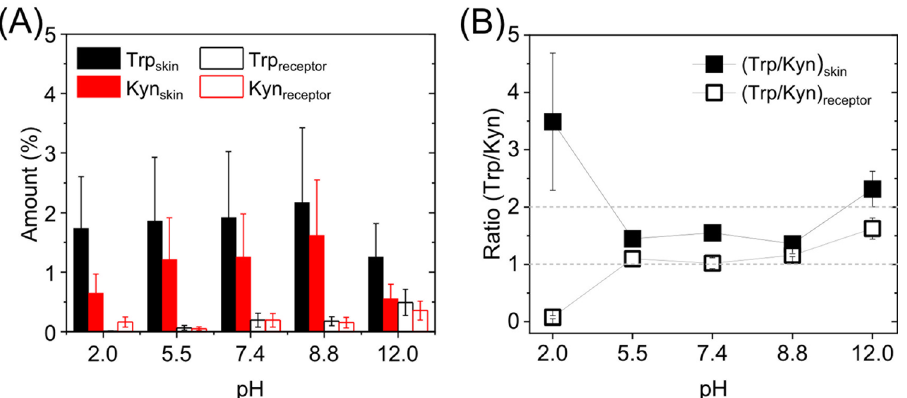
Figure 4. ( A ) Mass balance of Trp and Kyn between the skin membrane and the receptor solution as a function of pH (%). The number of replicates were n = 4 at pH 2.0; n = 3 at pH 5.5; n = 3 at pH 7.4; n = 3 at pH 8.8; n = 5 at pH 12.0. ( B ) The Trp/Kyn ratio based on the data in ( A ); n = 4 at pH 2.0; n = 3 at pH 5.5; n = 3 at pH 7.4; n = 3 at pH 8.8; n = 5 at pH 12.0 for (Trp/Kyn) skin and n = 3 at pH 2; n = 3 at pH 5.5; n = 3 at pH 7.4; n = 3 at pH 8.8; n = 5 at pH 12.0 for the (Trp/Kyn) receptor